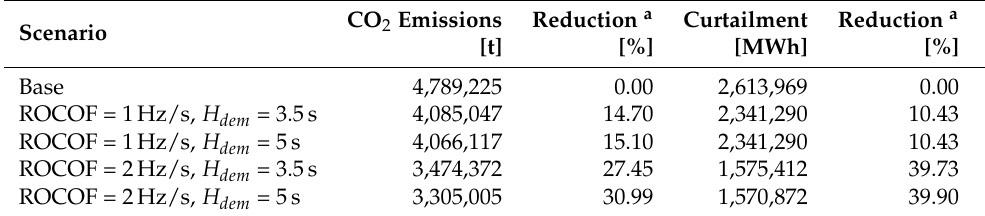
Table 4. CO 2 emissions and curtailment results of the analysed scenarios.